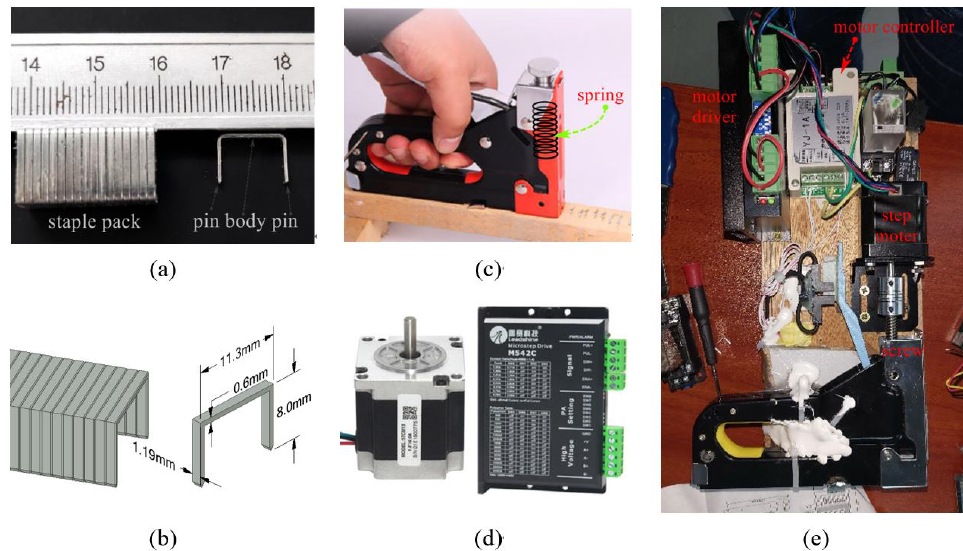
Figure 3. Staples and the automatic staple-inserting device: ( a ) photo of staples, ( b ) dimensions of the staple, ( c ) original stapler for wood fastening, ( d ) a step motor and its driver, and ( e ) the upgraded SIA.